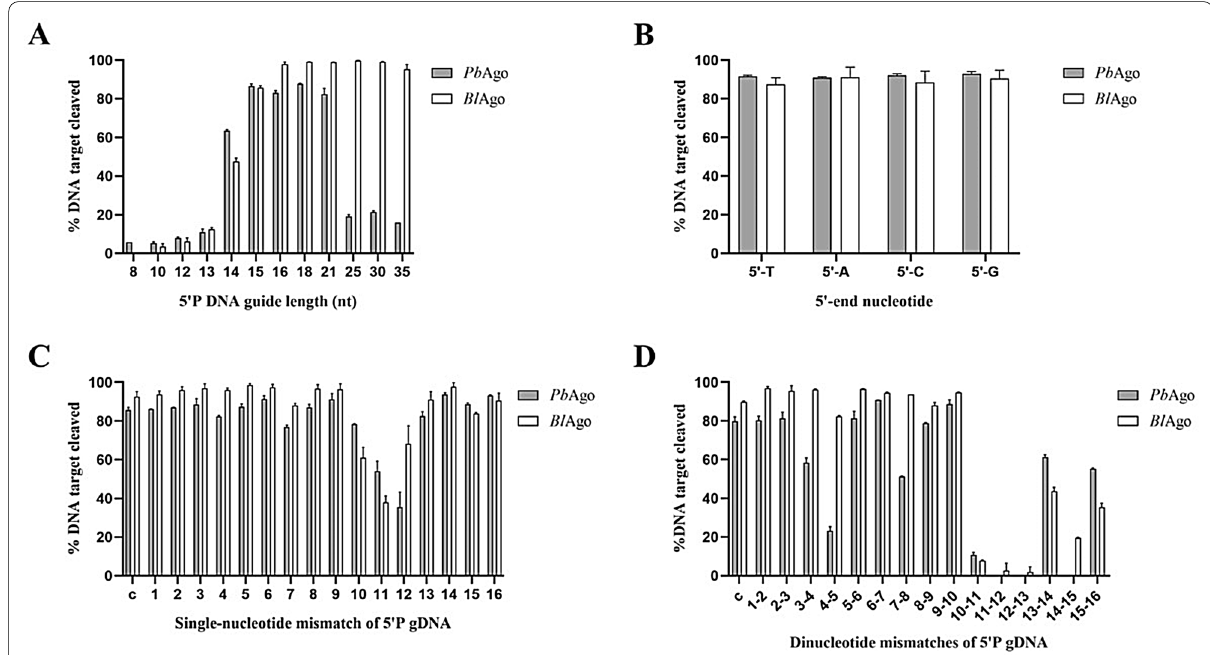
Fig. 3 Effect of guide sequence on Pb Ago and Bl Ago. a Effect of guide length on Pb Ago and Bl Ago. b Effect of the 5 ′ -terminal nucleotide of the 5 ′ -P gDNA on Pb Ago and Bl Ago. c Target ssDNA cleavage activity of Pb Ago and Bl Ago loaded with single-nucleotide mismatched gDNA. d Effect of dinucleotide mismatches on Pb Ago and Bl Ago activity. Error bars represent the SDs of three independent